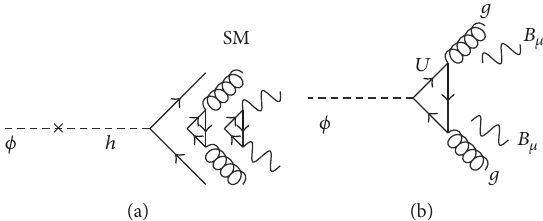
Figure 1: 𝜙 couples to the SM via the Higgs-portal mixing contribution (a) and via the loop induced couplings to two gluons and two hypercharge gauge bosons due to the VLQ 𝑈